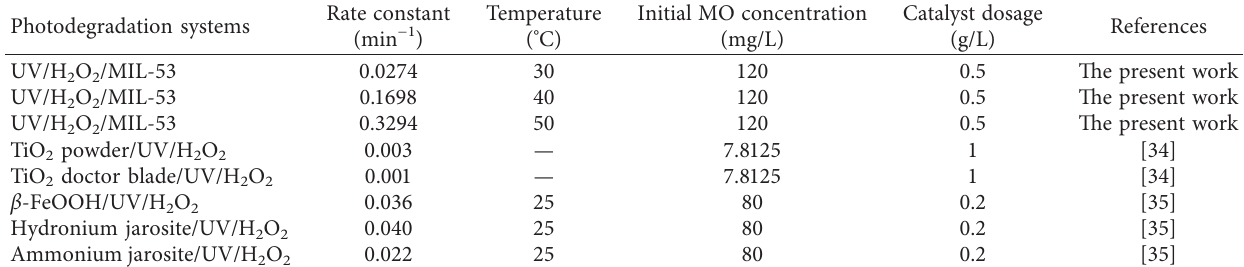
Table 1: The order rate constants ( k ) for MO photodegradation of the previous works. Photodegradation